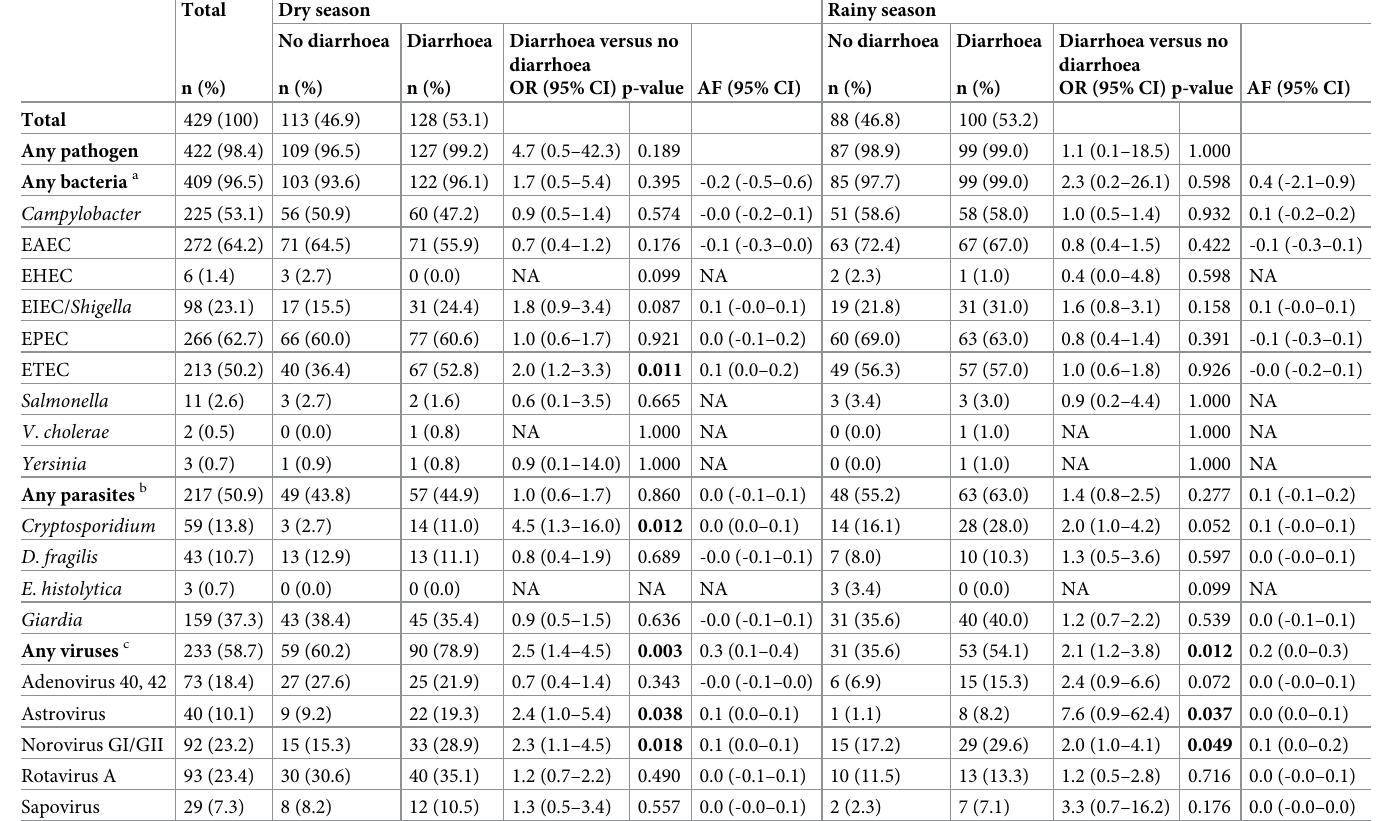
Table 3. Diarrhoeal pathogens in children with and without diarrhoea during the dry and rainy